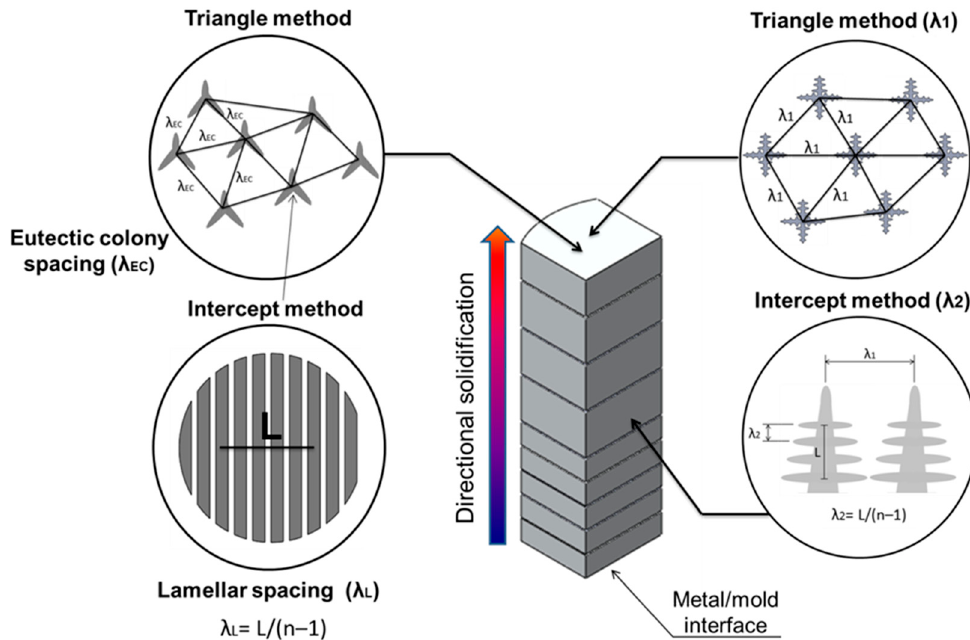
Figure 2. Schematic representation of samples extraction and of measurement methods used to quantify the length scale of the dendritic microstructure: λ 1 is primary dendritic arm spacing, λ 2 is secondary dendritic arm spacing, λ EC is eutectic colony spacing, λ L is lamellar spacing, ‘L’ is the length of the line and ‘n’ is the number of intercepted phases.